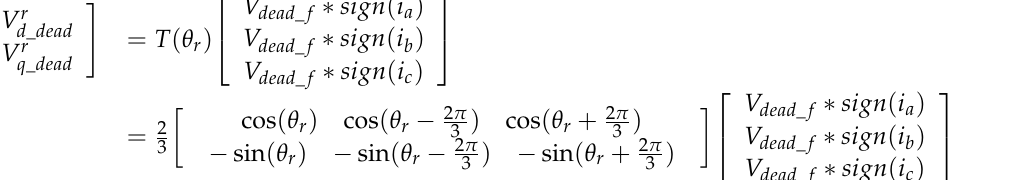
In order to know the exact magnitude of the disturbance voltage, the current value In this paper, the disturbance voltage generated during dead time is estimated using I at the point when the diode is conducted must be known exactly. However, in order an observer. The disturbance voltage to be estimated can be expressed as Equation (8), diode where V dead is the unexpected disturbance pole voltage applied to the motor by each phase to accurately measure the magnitude of the phase current of the motor, it must be meas- current direction, V diode is the voltage loss caused by the power switch elements and diodes, ured at the point when the voltage vector is applied as a zero vector. With these charac- and V dead _ f is the total disturbance voltage during dead time. V dead _ f can be expressed as teristics, the complex device drive method that senses the current value at the switching Equation (9) through the coordinate transformation on the d - q -axis coordinate plane used frequency, i.e., the highest point or lowest point of the carrier wave, is adopted and used. for control. This is a control method that reflects the characteristics of the DSP (Digital Signal